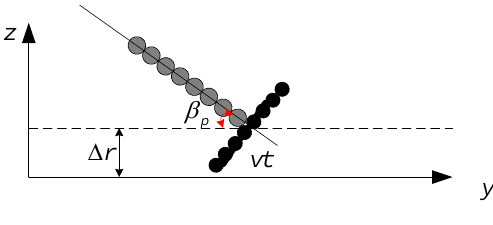
Figure 11. Geometry of heave and pitch in the y - z plane.